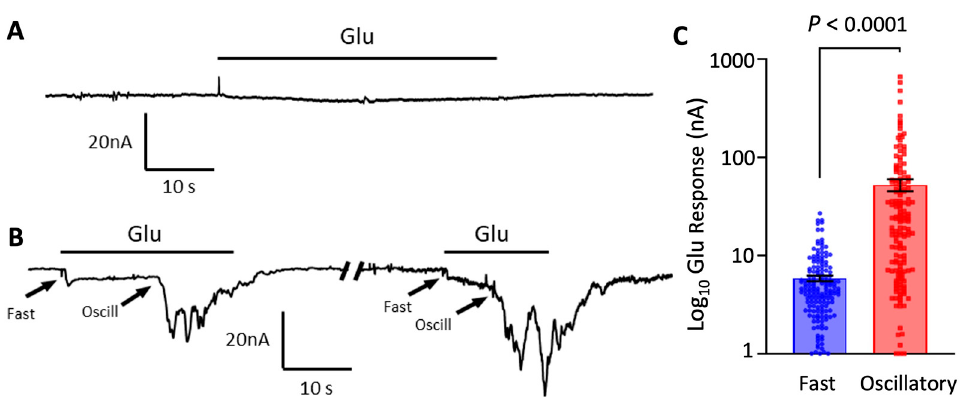
Figure 1. The effects of 1 mM glutamate (Glu) on oocytes microtransplanted with rat cortex synap- tosome membranes. Representative two electrodes voltage clamp responses to 1 mM Glu on a non-injected ( A ) and a microtransplanted oocyte ( B ). Recordings were done 24–28 h after injection. A subset of microtransplanted oocytes showed an immediate fast-activating inward current followed by a delayed oscillatory current. Arrows indicate the beginning of the response. Oscillatory currents appeared after a delay within a range of 3–38 s. ( C ) Amplitude of fast and oscillatory Glu responses in microtransplanted oocytes showing both responses (52.2 ± 7.3 nA; n = 159 oocytes from 17 frogs; Mean ± SEM). Paired t